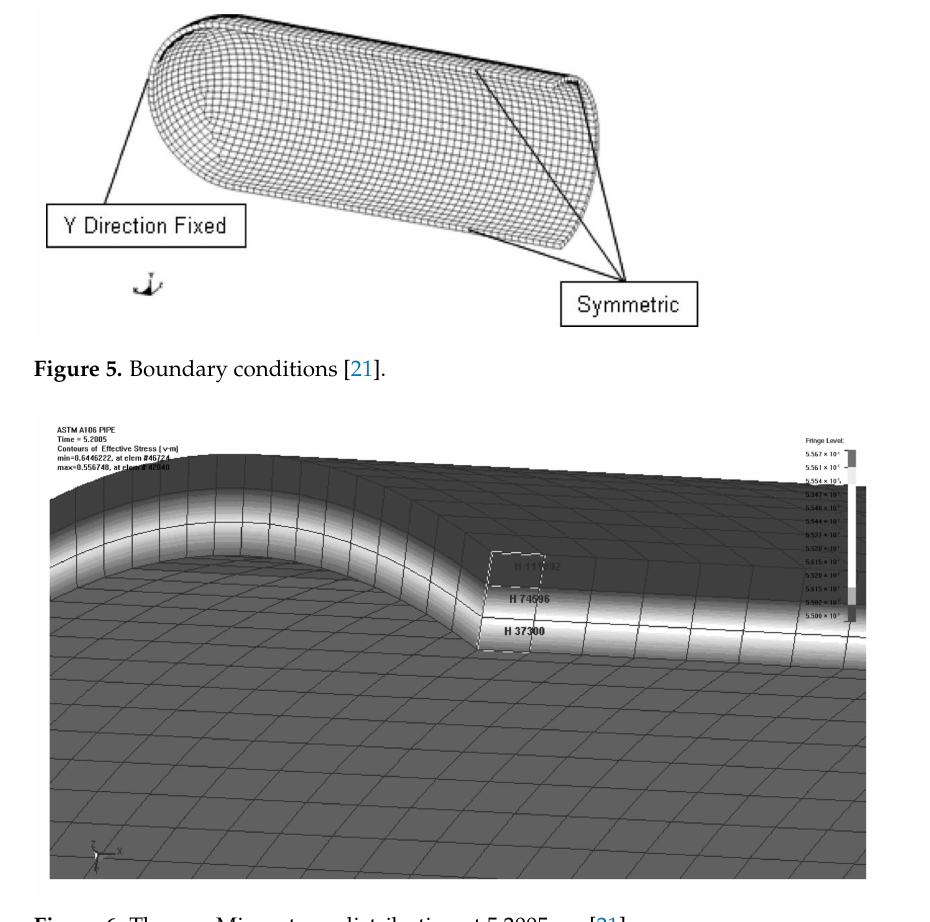
Figure 6. The von Mises stress distribution at 5.2005 ms